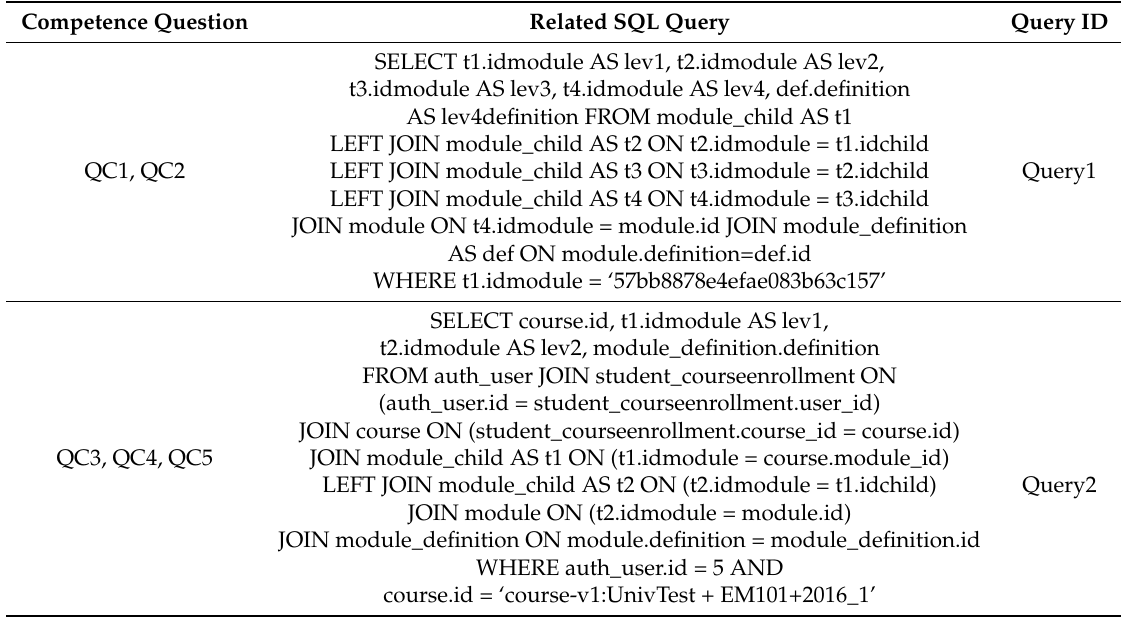
Table 8. Queries used in the system related to each issue of